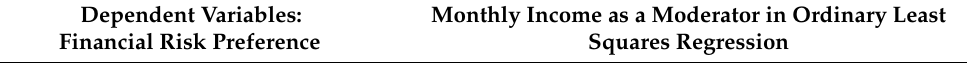
Table 9. The moderation effect of monthly income on the relationship between morningness and financial risk